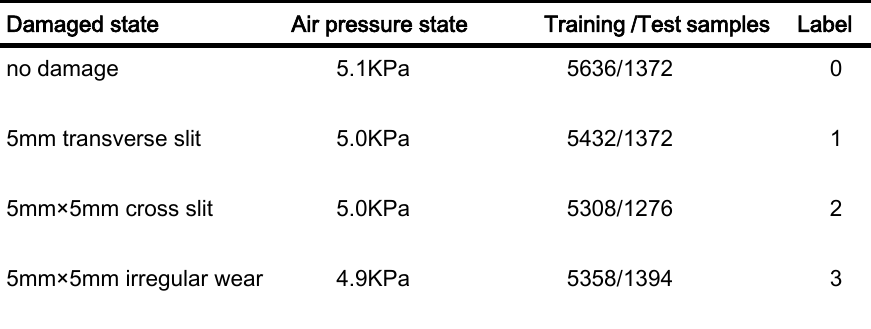
Table 1. Introduction to training samples and testing samples.